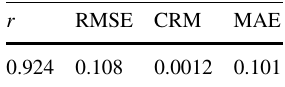
Table 3 The Fuzzy -kNN model